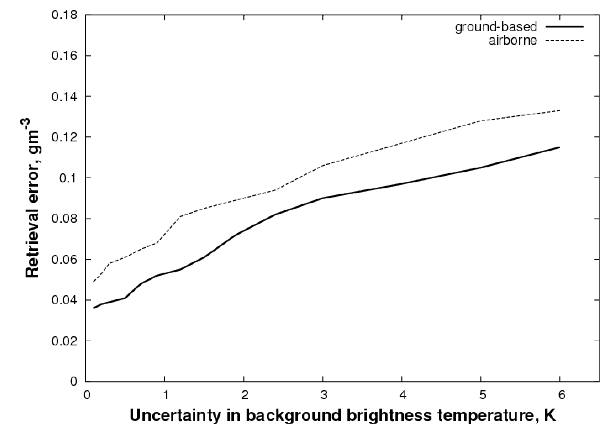
Figure 7. The retrieval error as a function of radiometer noise level. As expected, the retrieval error increases with radiometer noise level for both the ground-based and airborne setups. The stratocumulus cloud case is used for this sensitivity test.